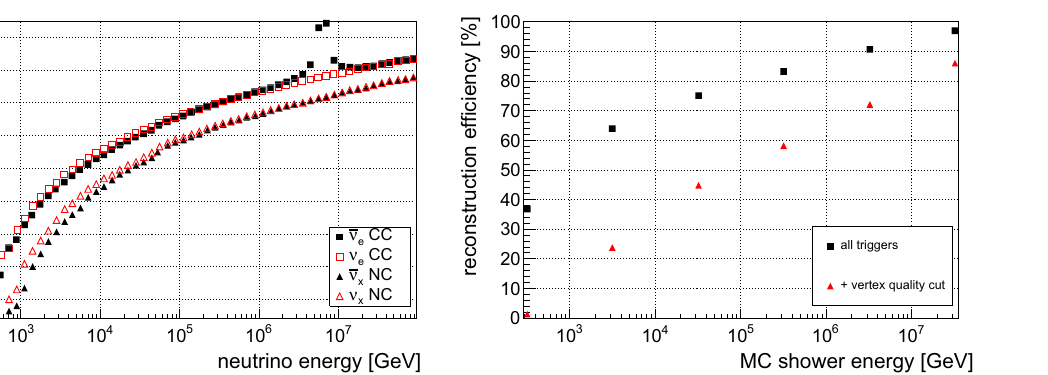
triangles ) NC events. Right reconstruction efficiency for all triggered shower-like events ( black squares ) and including the vertex-quality cut ( red triangles ) as a function of MC shower